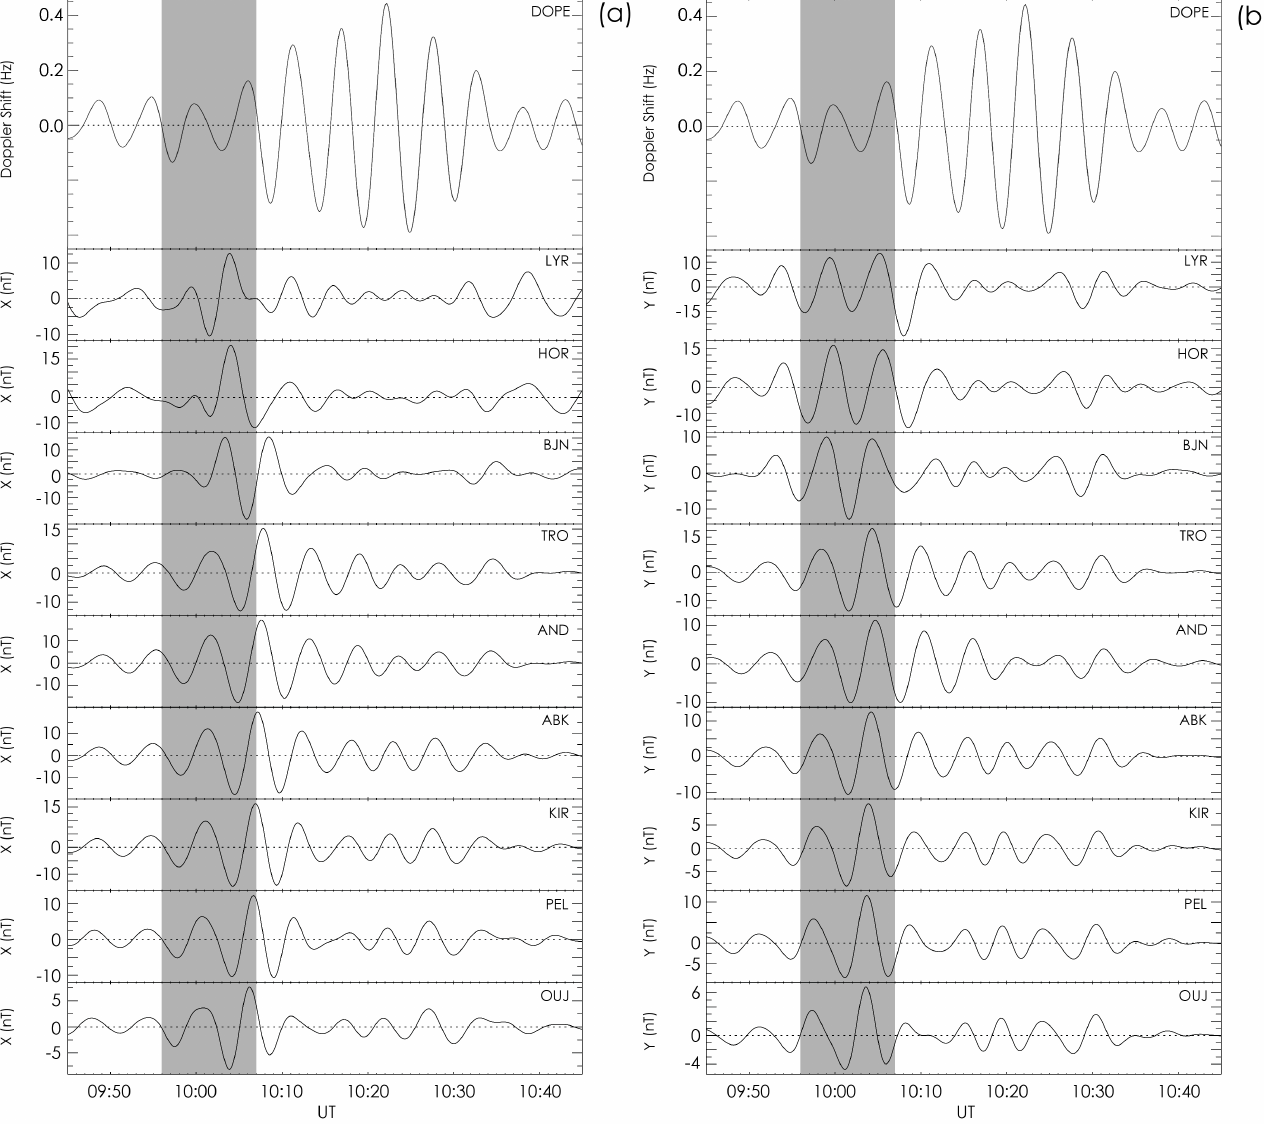
Fig. 3. DOPE and IMAGE Magnetometer data for the ULF wave event on 16 April 1998. Panels (a) and (b) display data from the X and Y components of nine stations of the IMAGE magnetometer array bandpass filtered between 250 and 500s. The upper panel in both (a) and (b) show the bandpass filtered DOPE data also excluding variations with time periods outside of the range 250s to 500s, resampled from 12.8s to 10.0s. The grey shaded region shows the possible range of arrival times of the effects of the solar wind dynamic pressure increase as measured by the ACE spacecraft. The time series plots have been scaled individually to provide the highest clarity of the wave